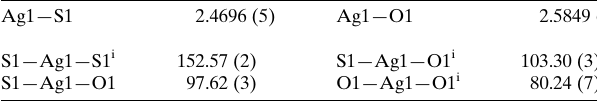
Table 1 Selected geometric parameters (A˚ , (cid:5) ) for I .